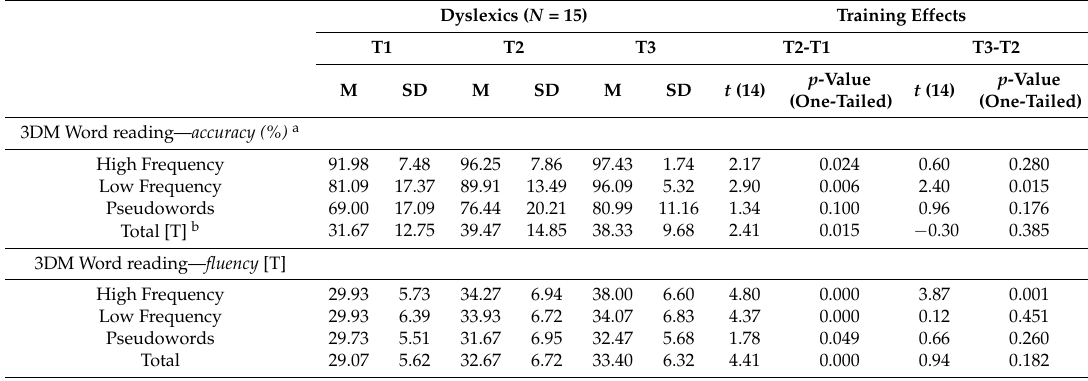
Table A1. Reading scores and training